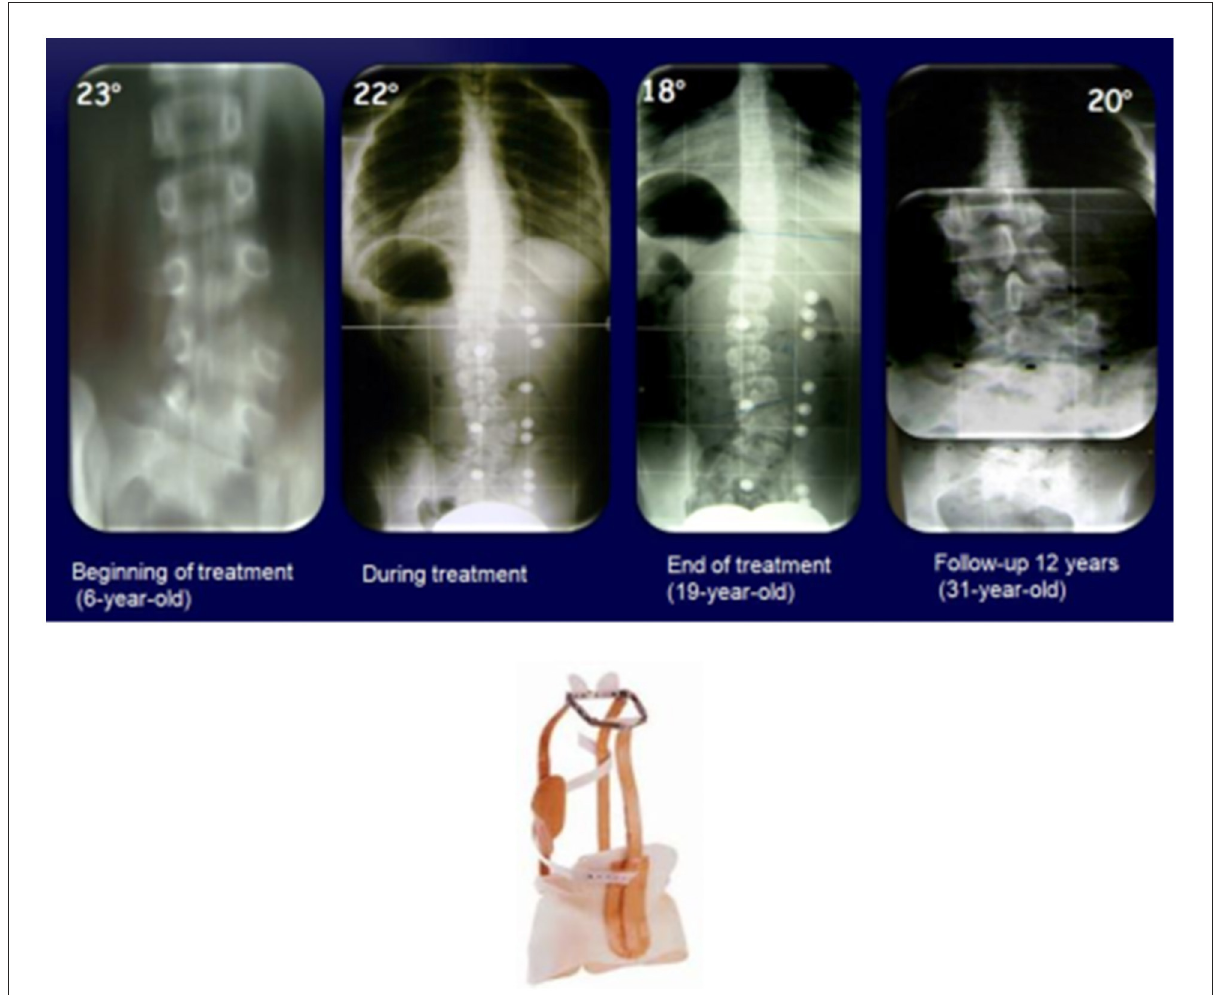
FIGURE1 A 6-years-old girl with a hemivertebra in L5 and a curve L1-L5 (S1), with urinary malformation associated, treated with the Milwaukee brace in the first years and then the